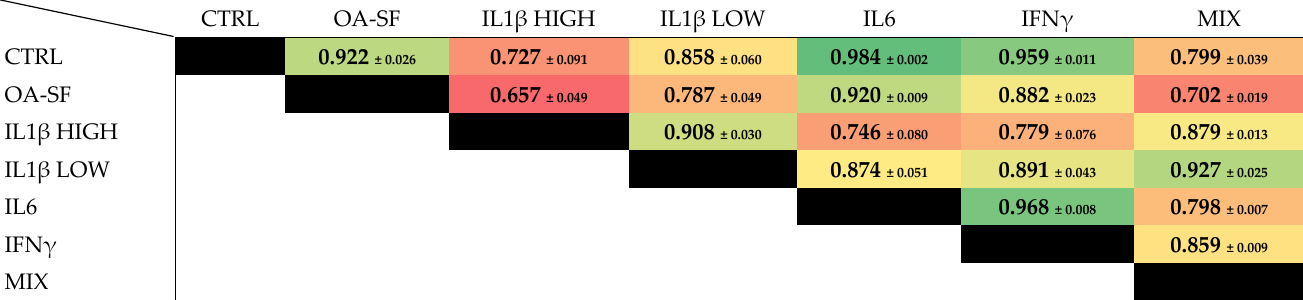
Values indicate mean R 2 with standard deviation. Background color shade indicates degree of cor-